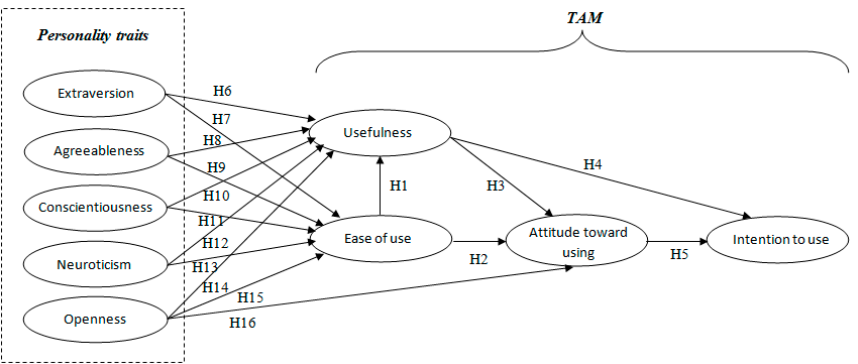
Figure 1. Proposed research model of personality and intention to use gamified learning environ-